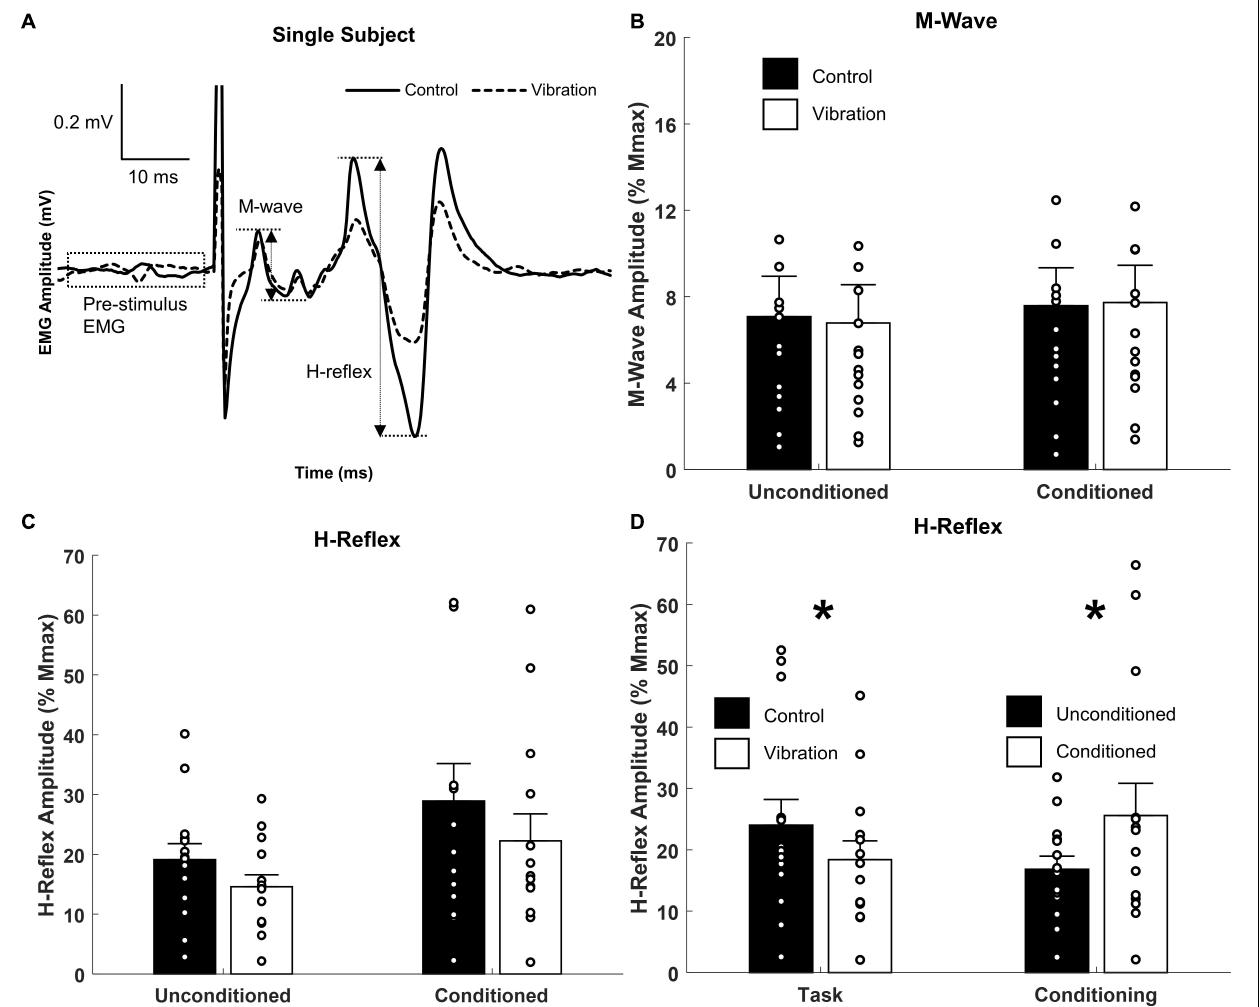
FIGURE 4 | Effects of upper limb vibration on Hoffmann (H-) reflex. (A) Single subject traces highlighting the suppression of H-reflex amplitude during ULV while M-wave is maintained constant. Solid traces indicate the average of 20 sweeps during CONTROL, whereas dotted traces indicate the average trace during ULV. (B) Group average of M-wave amplitude across conditions indicating the same descending input was provided across condition. (C) Group averages of H-reflex amplitude with and without ULV for both unconditioned and conditioned reflexes. (D) Group average of H-reflex amplitude pooled across task (ULV vs. CONTROL) and effect of conditioning. All single subject data is included as clear circles. * Indicates significant difference in H-reflex amplitude. Values are mean ± SD ( p <